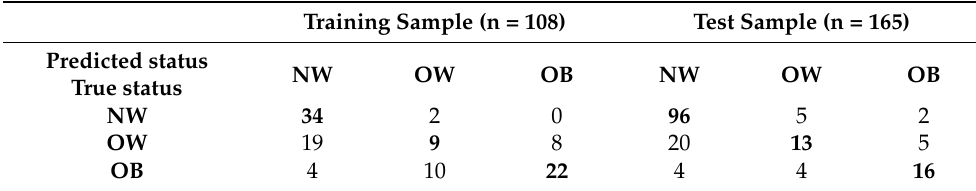
Table 4. Confusion